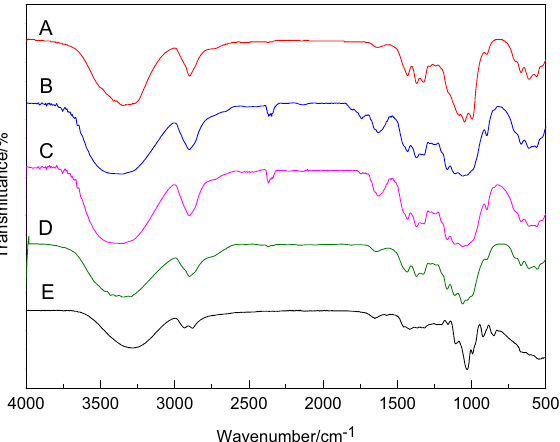
Figure 1. FTIR spectrum of A (cellulose standard sample), B (Rabdosia cellulose), C ( R. rubescens MCC), D (MCC standard sample) and E (MCC membrane).